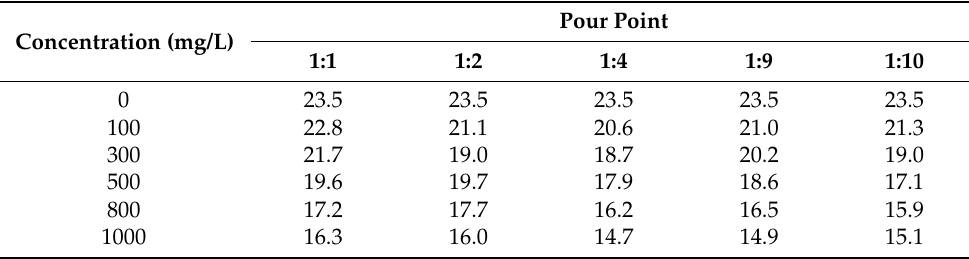
Table 3. Effect of concentration on the pour point of oil samples at the volume ratio of modified polystyrene to diesel.